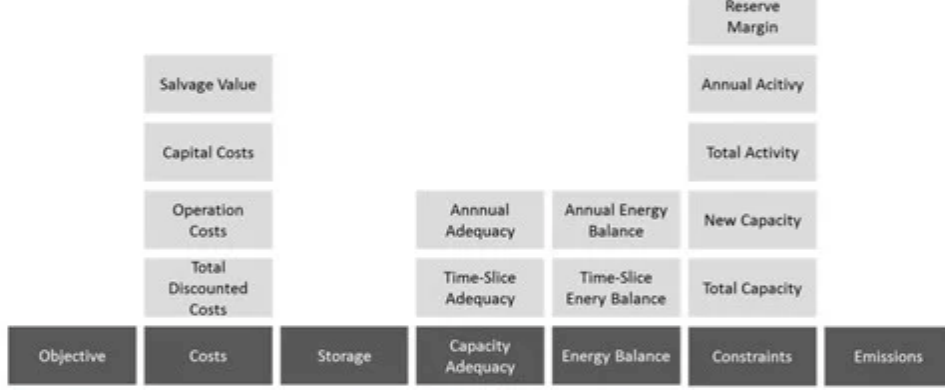
Figure 1. OSeMOSYS’ Modular Structure. Based on [42]. The objective function of OSeMOSYS is to develop a least cost energy system con- figuration, subject to various expansion and operational constraints. A full mathematical description is available from Howells et al.